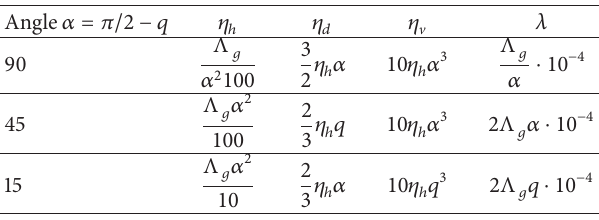
Table 1: The analytical expressions for the constants 𝜂 𝑑 , 𝜂 ℎ , 𝜂 V , and 𝜆 in the resistance force formulation.